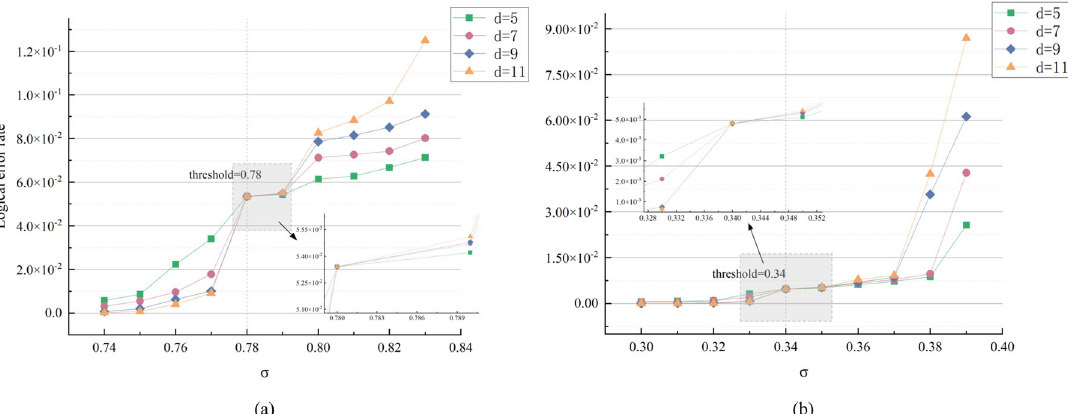
Fig. 7 Schematic diagram of threshold value under neural network decoder. a The image on the left shows the low-performance decoder under the neural network decoder for the fi rst error type. b The effect on the right shows that the threshold effect for the second noise model under the pure error decoder is